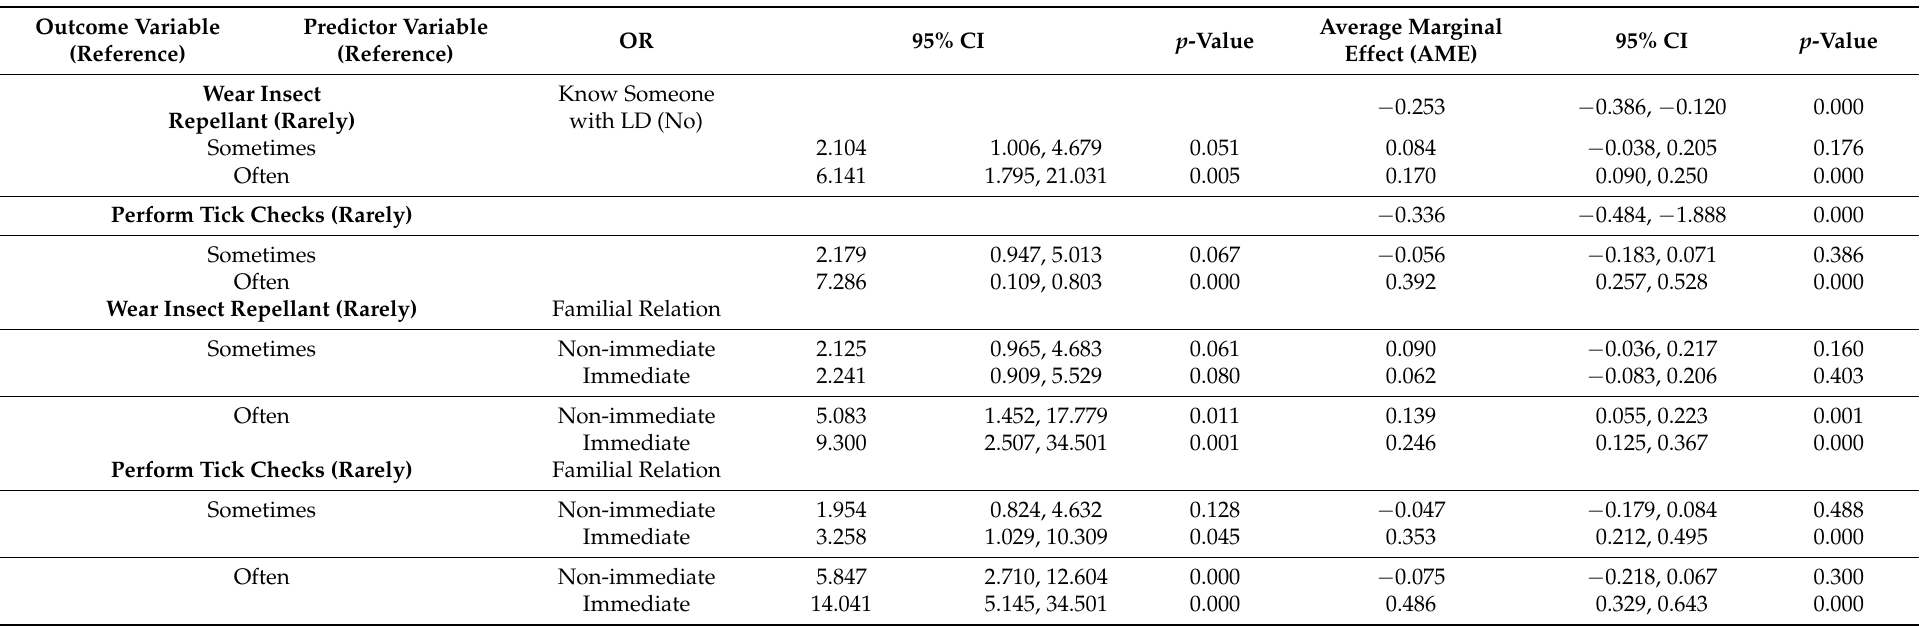
Table 3. Odds of using preventive measures of Lyme disease by knowing someone with Lyme disease and degree of relation, controlling for age and